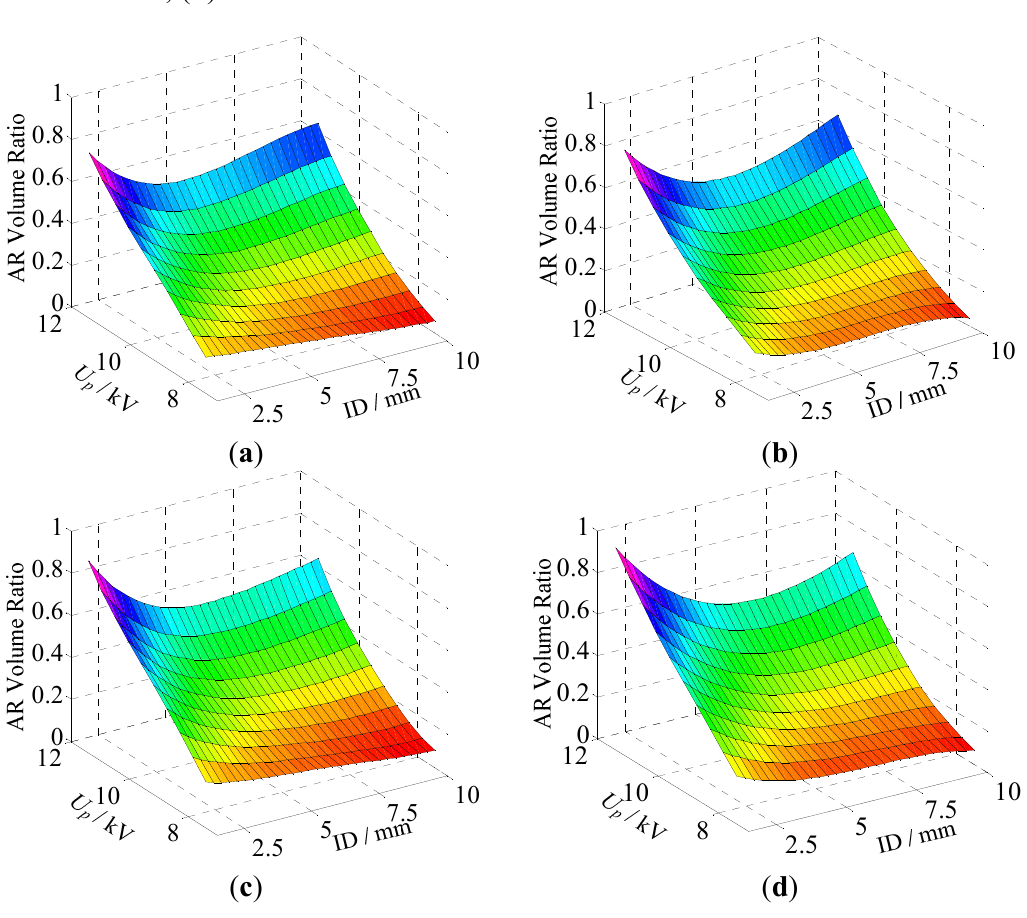
Figure 11. AR volume ratio obtained using COMSOL as a function of applied voltage and ID for different configurations (NL/INRA): ( a ) 3.5 + 2/45°; ( b ) 3.5 + 2/0°; ( c ) 3.5 + 3.5/45°; ( d ) 3.5 +